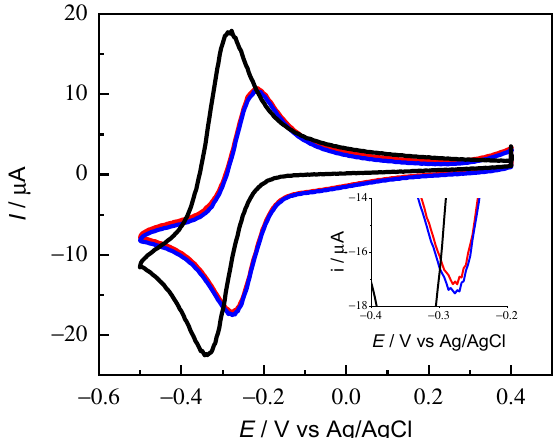
Figure 1. Cyclic voltammetry of [Cu II TPMA] 2+ in H 2 O + 0.1 M NaBr ( ▬ ), and in the presence of 10 vol% OEOMA 500 ( ▬ ), and in the presence of ( ▬ ) cellulose(H)-BriB recorded at T = 25 °C on a GC electrode at 0.2 V/s.